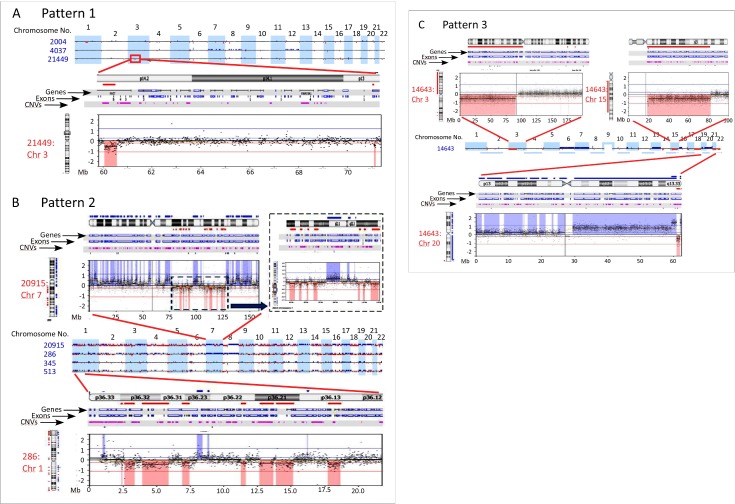
Patterns of genomic aberrations highlighted by high-resolution aCGH in CRC.a) Shows pattern 1 from 3 patients as examples (upper 22 autosomes). The zoomed inset focused on an area of chromosome arm 3P with 2 small deletions. b) Shows 4 cases of CRC with pattern 2. Notice the large number of small aberrations that alternate between gain-baseline-loss. Insets show zoomed in picture of chromosome 7 from one patients (upper panels) and chromosome 1 from a different case. Notice how well-demarcated and clear are these alternating aberrations. c) Shows a case with pattern 3, which involves copy number alterations of chromosomal arms or whole chromosomes (Insets). In all figures deletions are shown in red and deviate below the 0 (log2 ratio) and gains are depicted in blue.